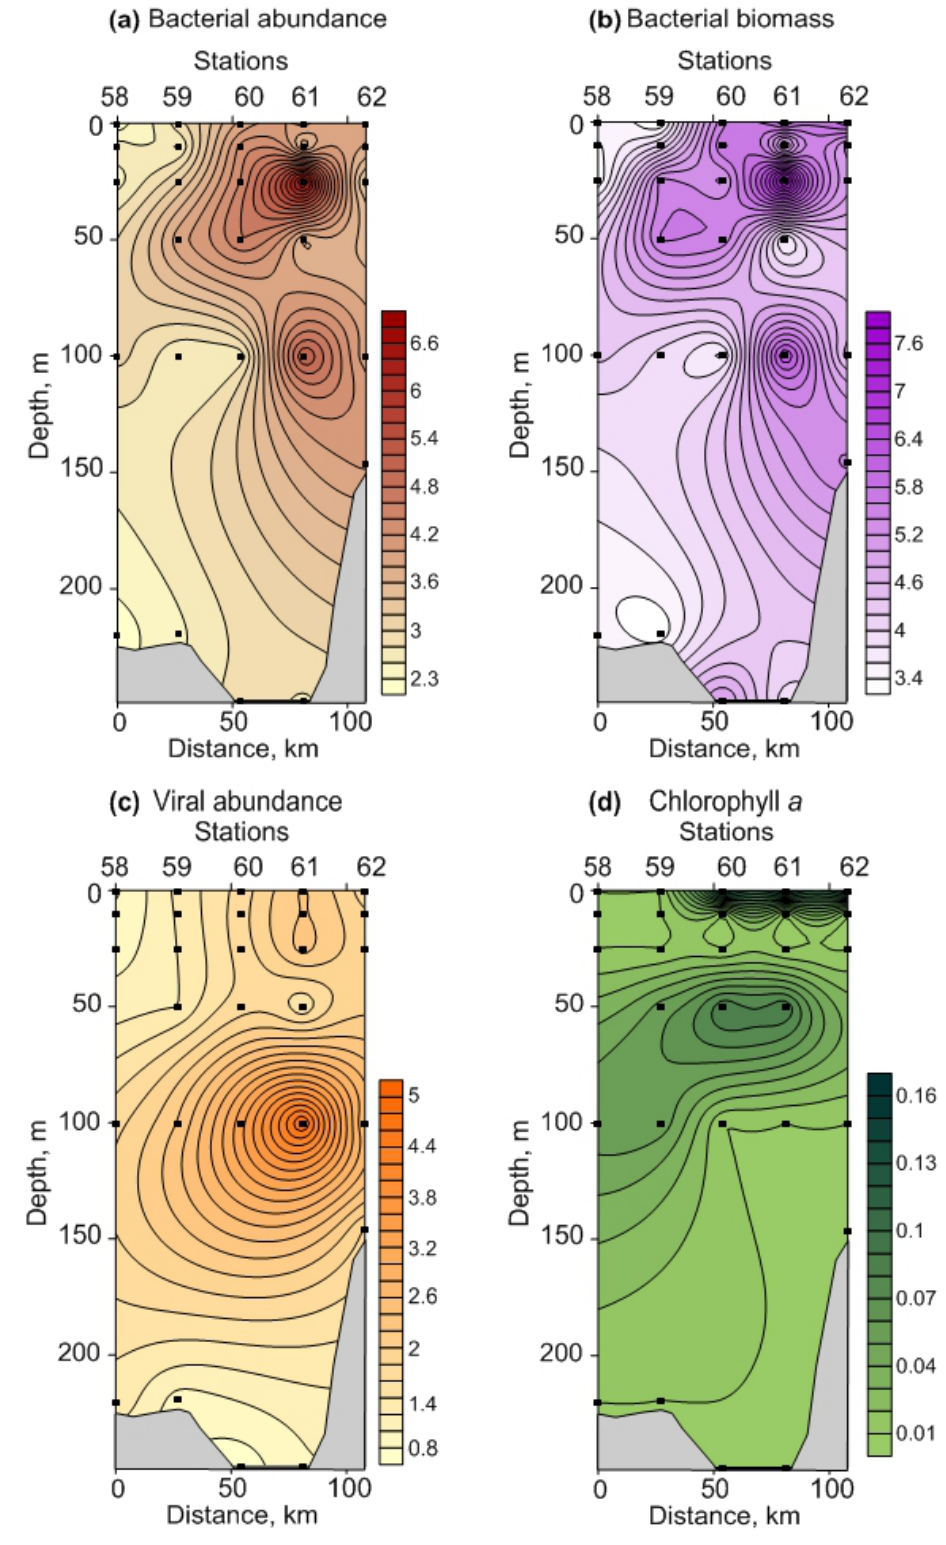
Figure 5. Vertical profiles of bacterial abundance, 10 5 cells mL − 1 ( a ), bacterial biomass, mg C m − 3 ( b ), viral abundance, 10 6 particles mL − 1 ( c ), and chlorophyll a , mg m − 3 ( d ) in the Southern Barents Sea, winter